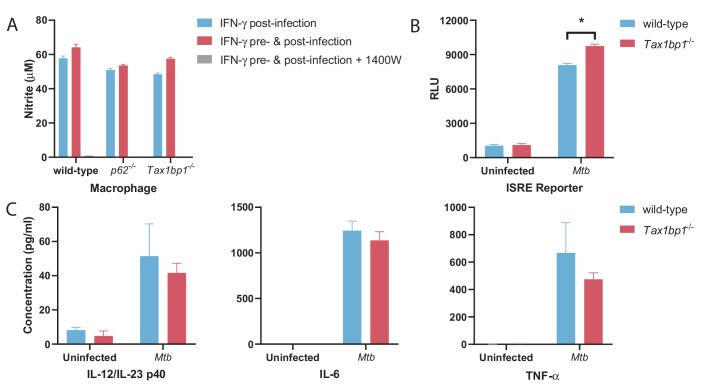
Nitrite and cytokine measurements from supernatants of macrophages infected with Mtb.(A) Infected macrophages were stimulated with IFN-γ in the presence or absence of nitric oxide synthase inhibitor (1400W), and nitrite was measured from the supernatants. Results are the means ± SEM for six technical replicates. (B) ISRE reporter activity was measured from the supernatants of uninfected or Mtb-infection macrophages. Results are the means ± SEM for two independent biological replicates. * p value less than 0.05 by t-test. (C) IL-12, IL-6, and TNF-α levels were measured from the supernatants of uninfected or Mtb-infected macrophages. Results are the means ± SEM for two independent biological replicates.